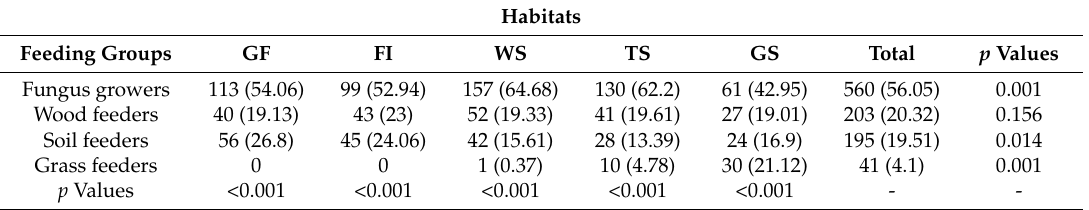
Table 3. Variation in relative abundances of termite feeding groups within the visited habitats.